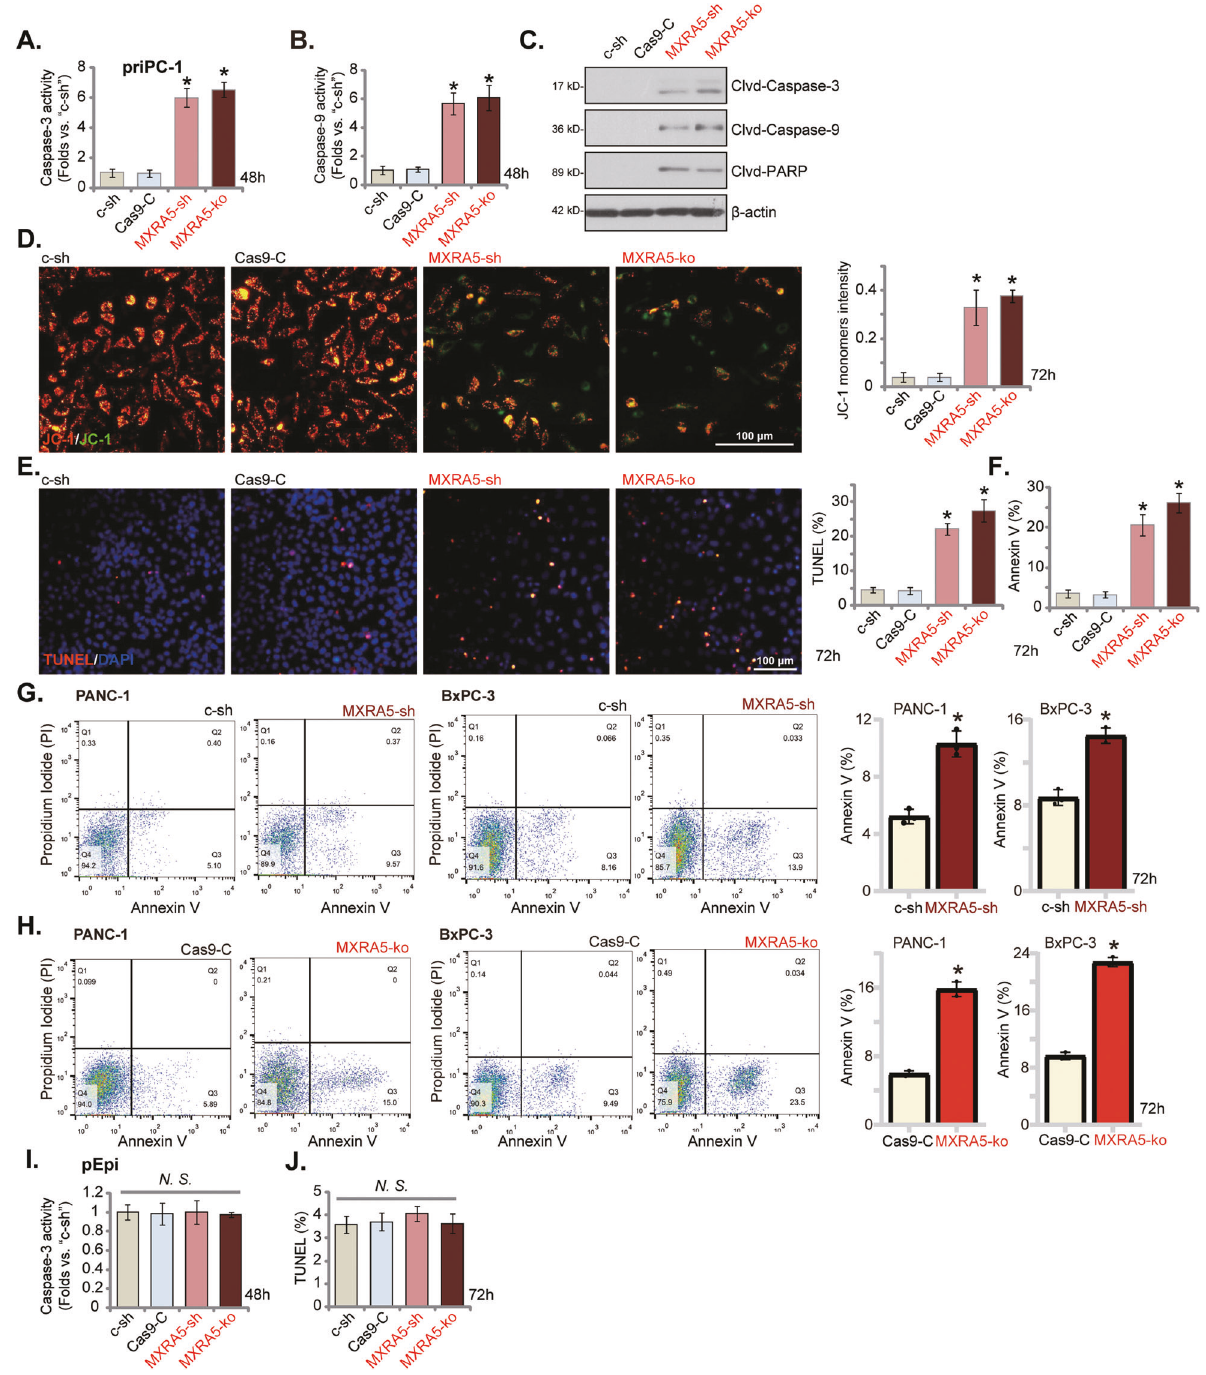
Fig. 3 MXRA5 silencing provokes apoptosis in pancreatic cancer cells. Puromycin-selected priPC-1 primary human pancreatic cancer cells ( A - F ) or the established cell lines (PANC-1 and BxPC-3, G and H ) or pEpi primary human pancreatic epithelial cells ( I and J ), with the MXRA5-sh- S1 ( “ MXRA5-sh ” ), the scramble control shRNA ( “ c-sh ” ), the sgRNA-CRISPR/dCas-9 MXRA5-KO lentiviral construct ( “ MXRA5-ko ” ) or Cas9 control construct ( “ Cas9-C ” ), were cultured for applied time periods, and the caspase-3 activity and the caspase-9 activity were tested ( A , B and I ); Expression of listed proteins was shown ( C ). Mitochondrial depolarization was examined by JC-1 staining ( D ). Cell apoptosis was examined by nuclear TUNEL staining ( E and J ) and Annexin V fl ow cytometry ( F – H ) assays. Error bars stand for mean ± standard deviation (SD, n = 5). * P < 0.05 versus “ c-sh ” cells. “ Clvd ” stands for “ cleaved ” . “ N.S . ” stands for P > 0.05. Experiments in this fi gure were repeated fi ve times. Scale bar = 100 μ m.